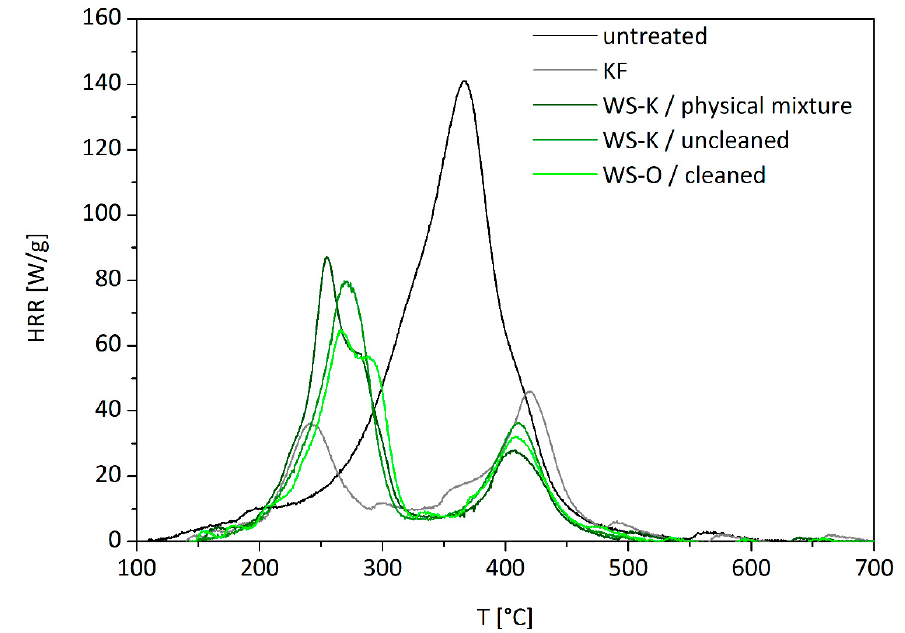
Table 6. Results from the pyrolysis-combustion flow calorimetry, test matrix wood fiber, additive content 10 wt.%.